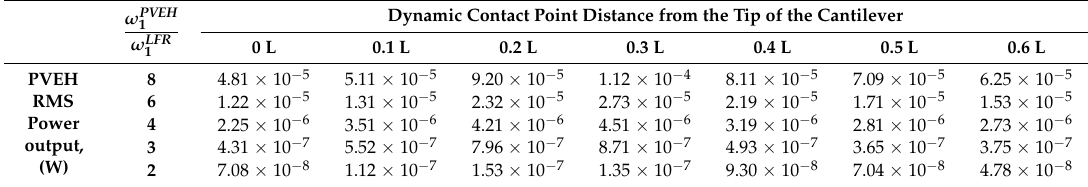
Table 4. RMS power output [W] of different tandem configurations at optimal resistive loads. ω PVEH